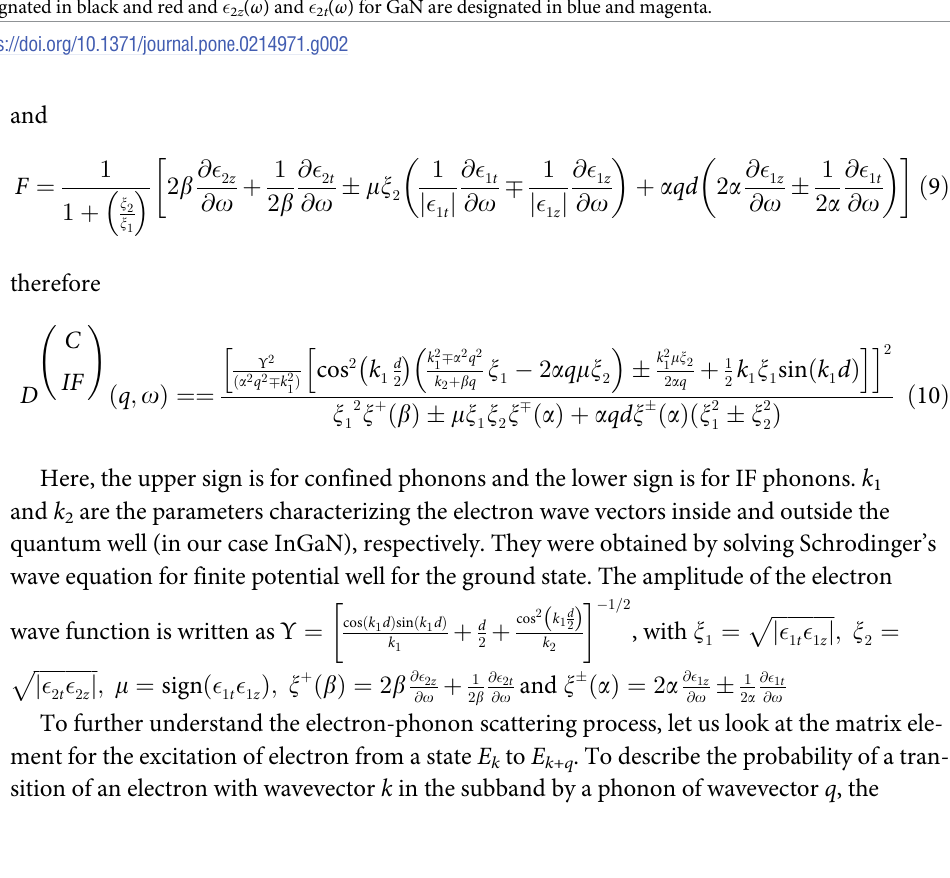
( ω ) and � 1 ( ω ) for InGaN are z t